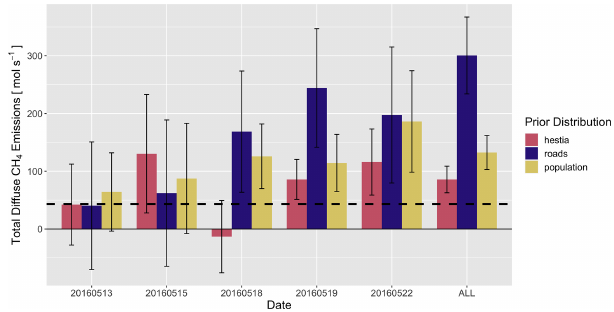
Figure 15. Total diffuse emissions from inversions using three different spatial distributions. The prior estimate of 43mols − 1 is shown with a dashed